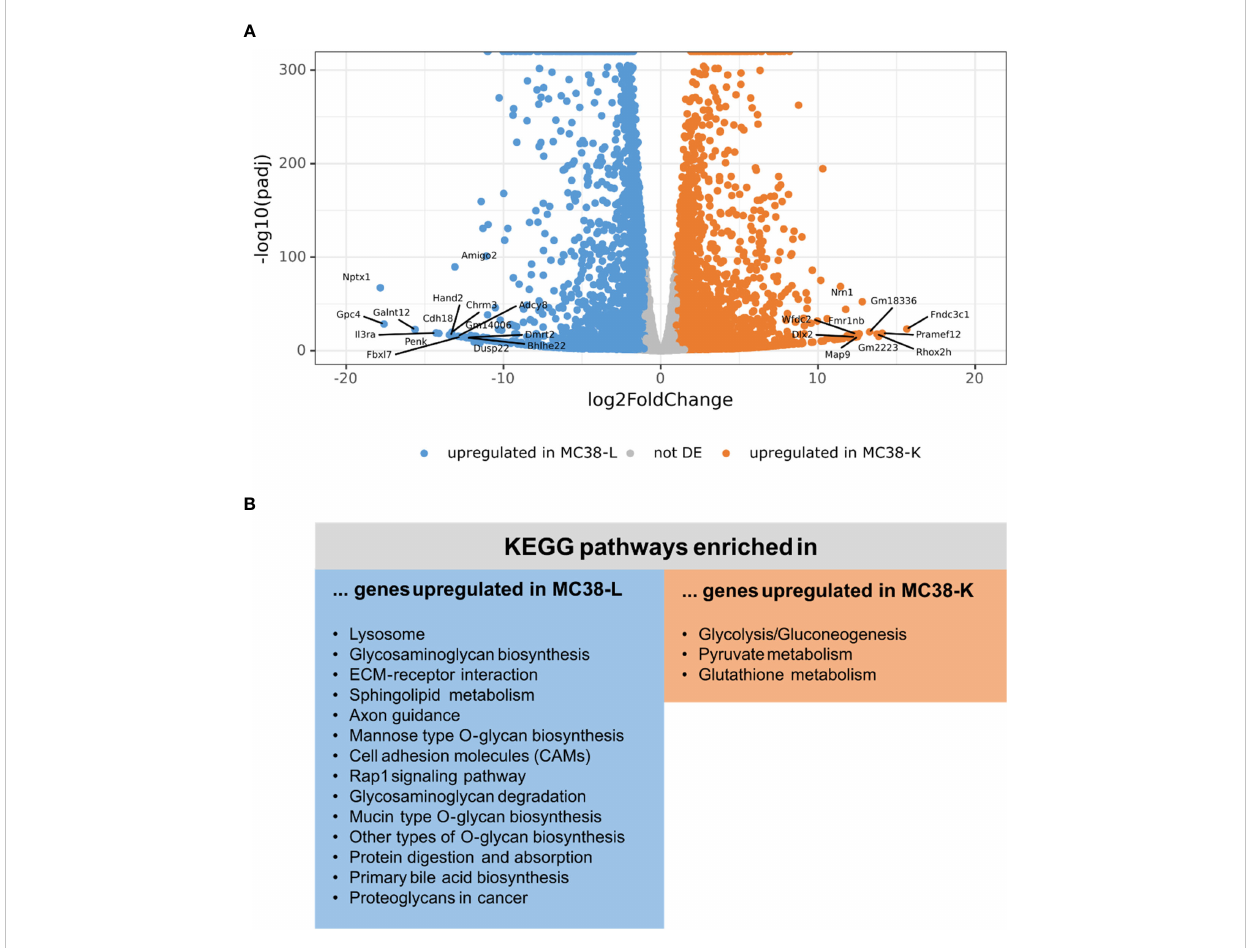
FIGURE 2 Differential expression analysis of MC38 cell lines indicates distinct transcriptomic pro fi les. (A) Vulcano plot of the differential expression analysis between MC38-K and MC38-L cells. The top 25 differentially expressed (DE) genes are labeled. (B) DE genes were subjected to pathway enrichment analysis. Signi fi cantly enriched KEGG pathways are shown (adjusted p-value <